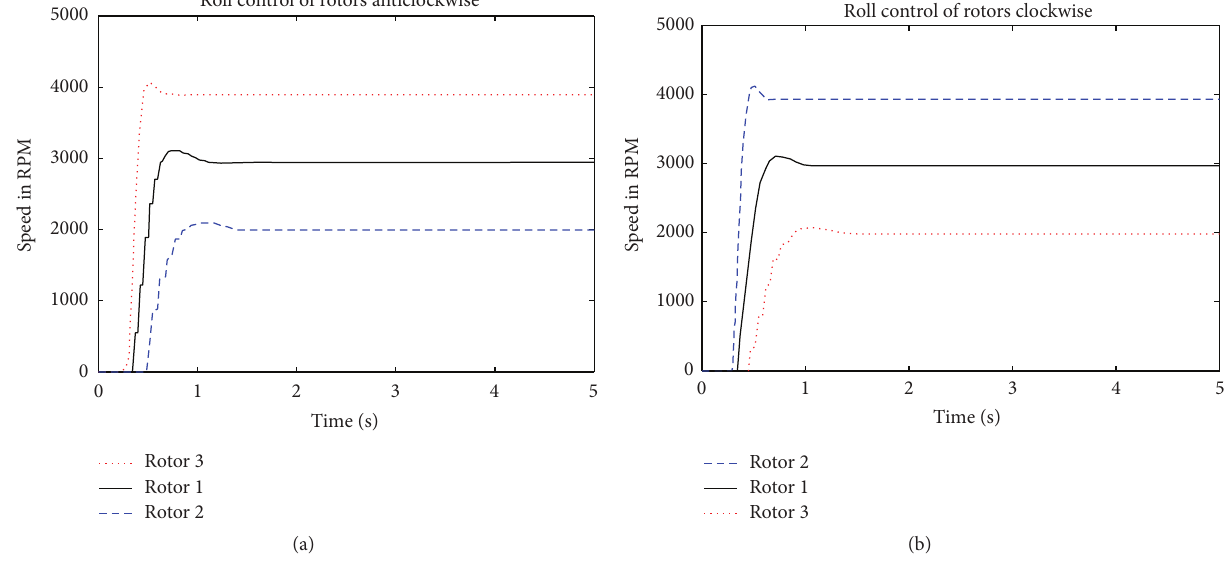
Figure 2: Roll Control Strategy with respect to anticlockwise (a) and clockwise (b)